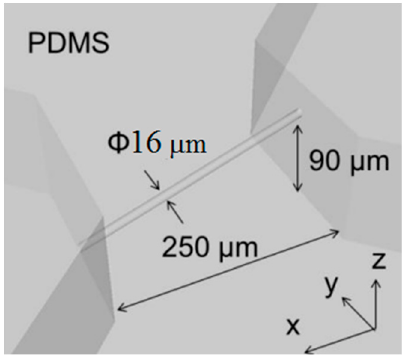
Figure 10. A CAD image design of 3D microfluidic devices for the replication of a microscopic vessel fabricated using FMEx.